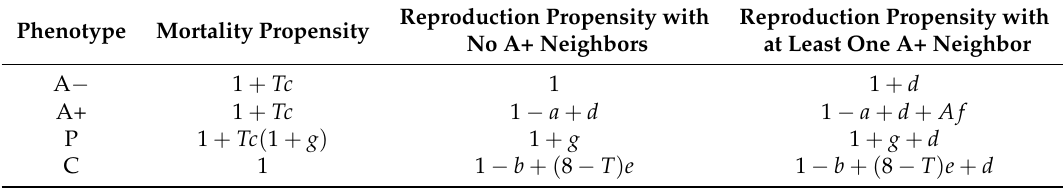
Table 4. Mortality and reproduction propensities in the spatial multiplayer game. Notation: T is the number of C neighbors, A is the number of A+